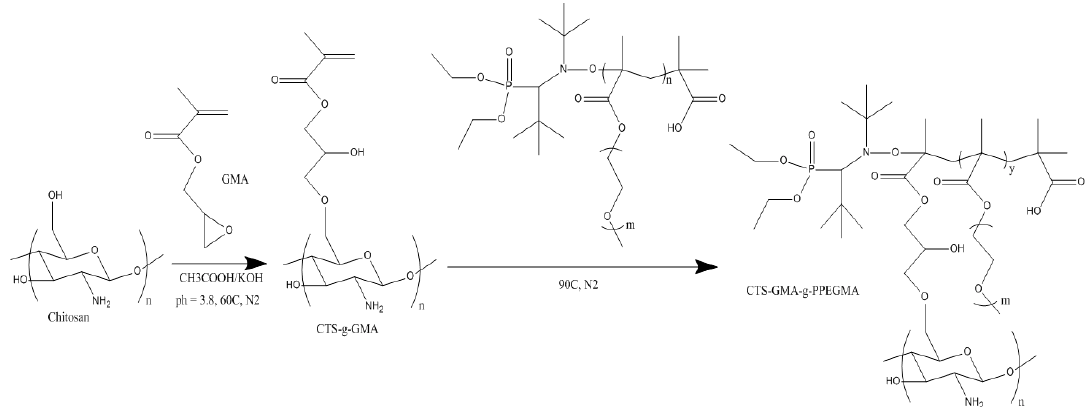
Figure 4. Synthesis of CTS- g -GMA-PPEGMA. CTS,1 g; 0.4 M acetic acid solution, 100 mL; 0.05 M KOH solution, 5 mL; hydroquinone solution (9.09 × 10 − 5 mol in 10 mL of H 2 O); glycidyl methacrylate